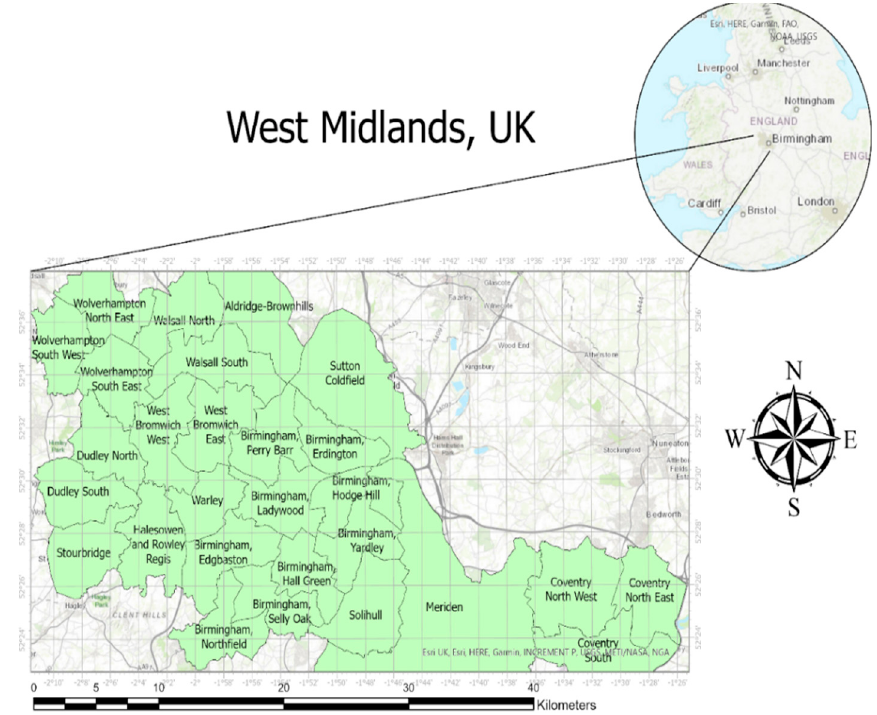
Figure 1. Map of the West Midlands, UK. The constituent boroughs are shaded in green. Table 1. Summary of WM socioeconomic status.